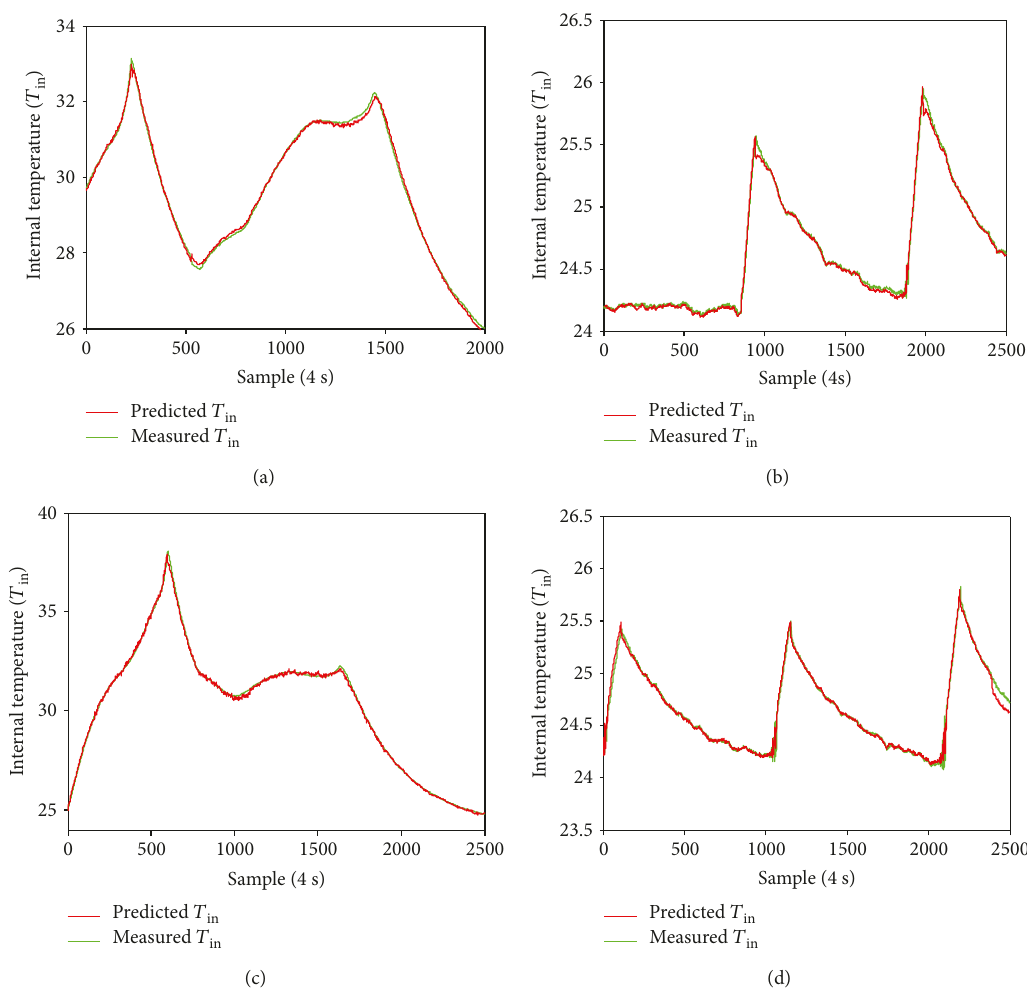
Figure 10: Validation results for T